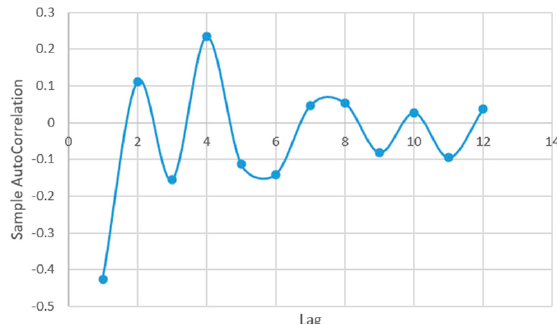
Figure A10. The PAC with transformation in square roots—BH series.